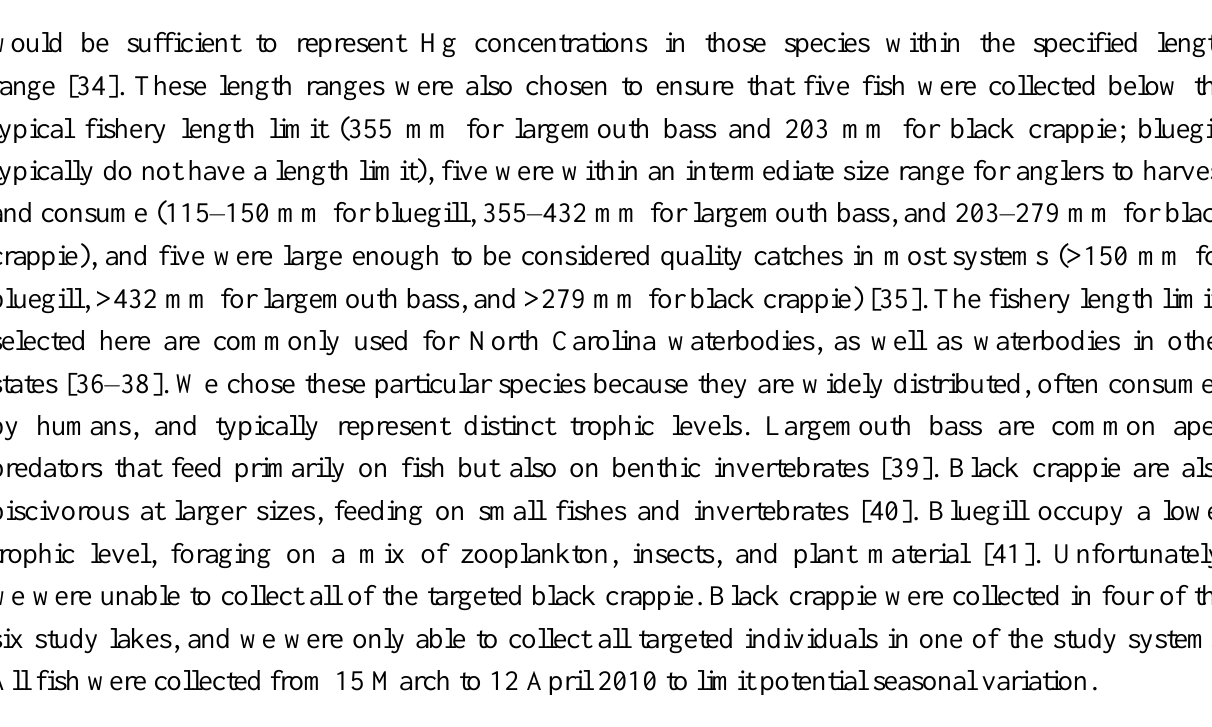
Figure 1. Locations of study lakes in North Carolina, USA, in relation to ecoregions as defined by Griffith et al. [42]; lakes were selected to represent a range of fish tissue Hg contamination based on a previous study